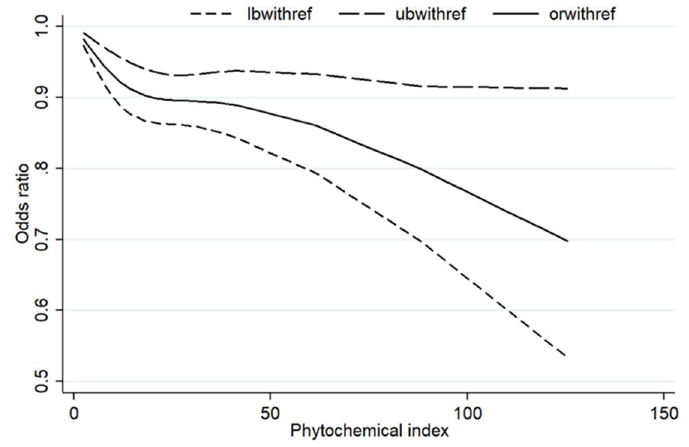
Figure 5. The dose–response analysis between PI and the risk of overweight/obesity. Abbreviations: lbwithref: lower bound of 95% confidence interval with reference; ubwithref: upper bound of 95% confidence interval with reference; orwithref: odds ratio with reference.